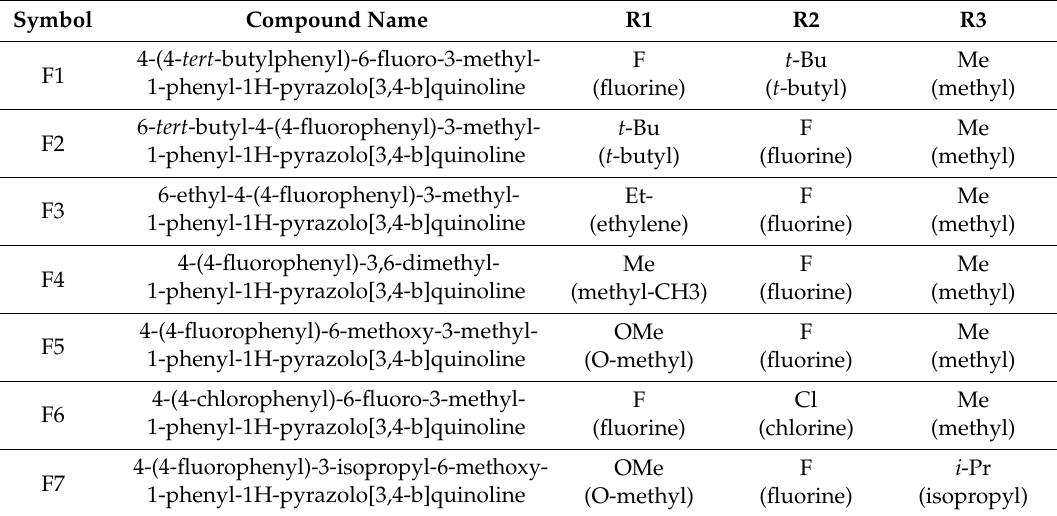
Figure 1. The one-pot procedure to prepare pyrazolo[3,4-b]quinolines F1–F7. Table 1. Symbols and names of investigated compounds and substituents R1, R2, R3.